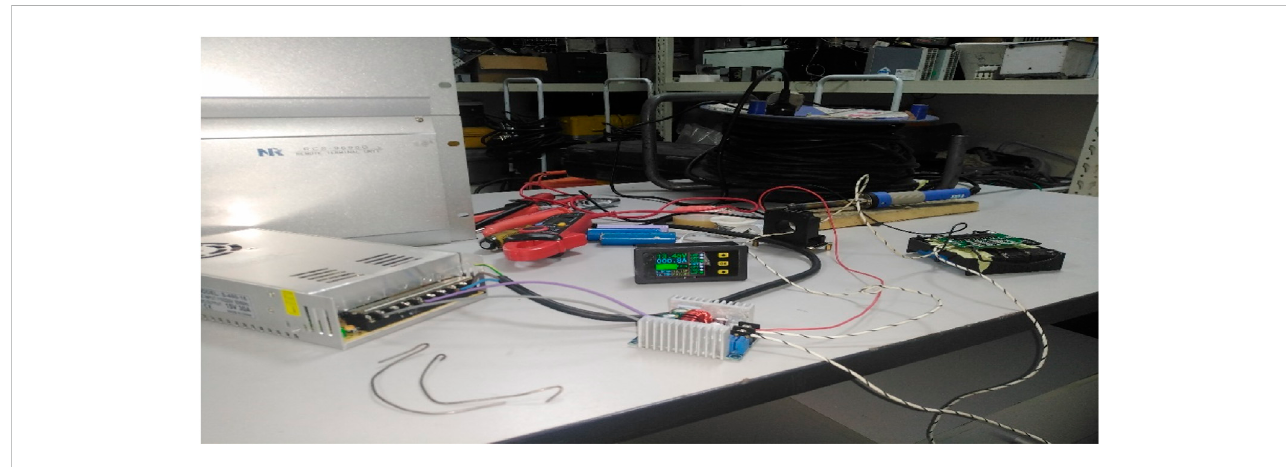
FIGURE 1 Experimental